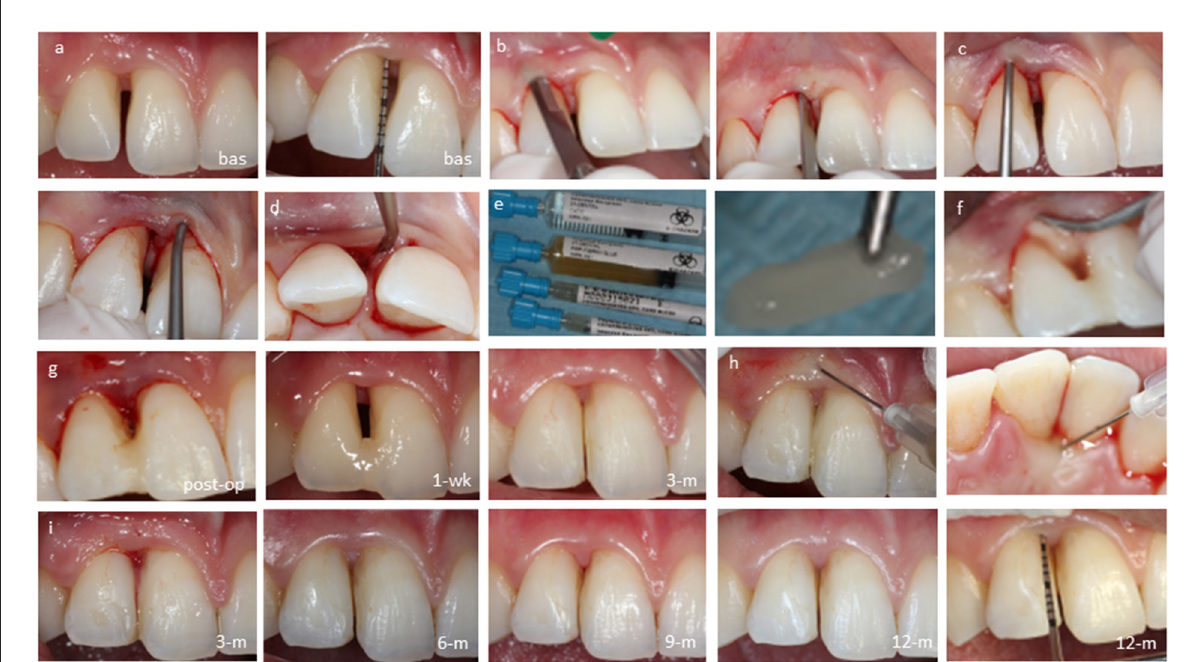
FIGURE2 Case-1, #12 mesial: (a) baseline status before anesthesia; (b) intrasulcular dissection of the periodontal attachment; (c) full-thickness gingival flaps retracted from the alveolar bone in a closed manner; tunneled papilla (d) soft-tissue retraction to obtain access to the osseous defect; (e) tissue-engineered biocomplex assembled chairside; (f) subgingival application of the biocomplex; (g) immediately post-operative with crosslinked autologous fibrin platelet lysate in place at 1-week, 3-month follow-up; (h) second application at 3-months of autologous clinical-grade alveolar Bone-Marrow Mesenchymal-Stem-Cells suspended in autologous platelet rich plasma lysate in an injectable solution; (i) immediately post-operative at 3-months and at 6-, 9- and